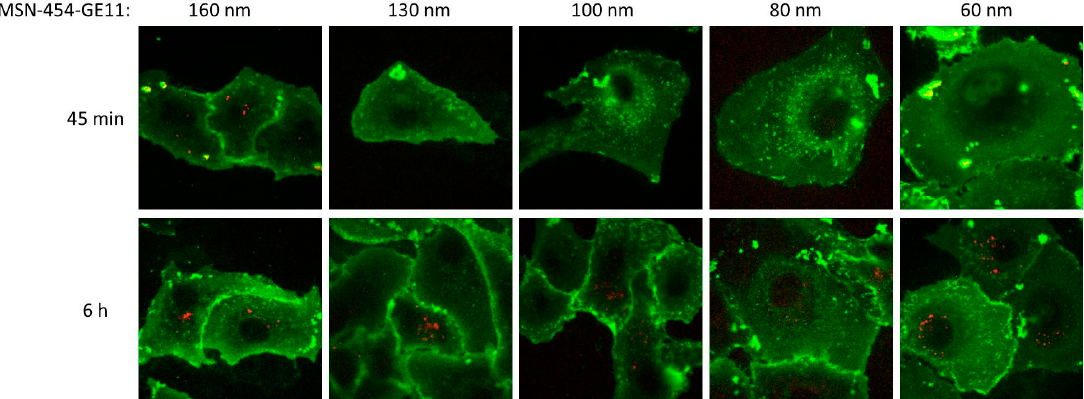
Figure 5. Representative confocal fluorescence microscopy images of Atto-633 labeled MSN-454-GE11 (red) with particle sizes in the range of 160 nm to 60 nm after 45 min (upper panel) and 6 h (lower panel) incubation on WGA488-stained T24 cells (green). For a statistical evaluation of particle-size-dependent uptake, see Figure S9, SI.